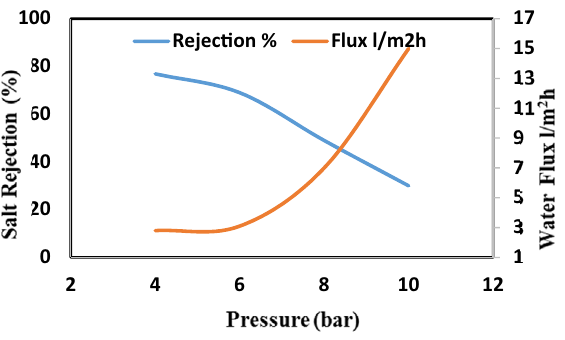
Figure 10. Salt rejection and water flux versus feed pressure of CA-RO membrane with 100% NRCA membrane.